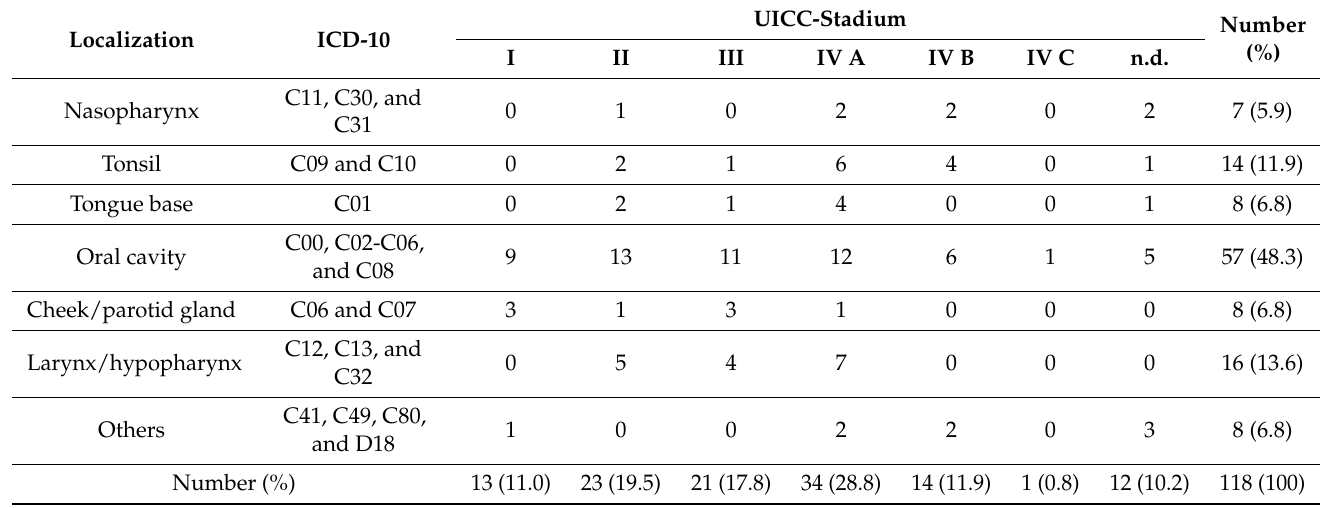
Table 1. Tumor localization and tumor stage according to ICD-10 and